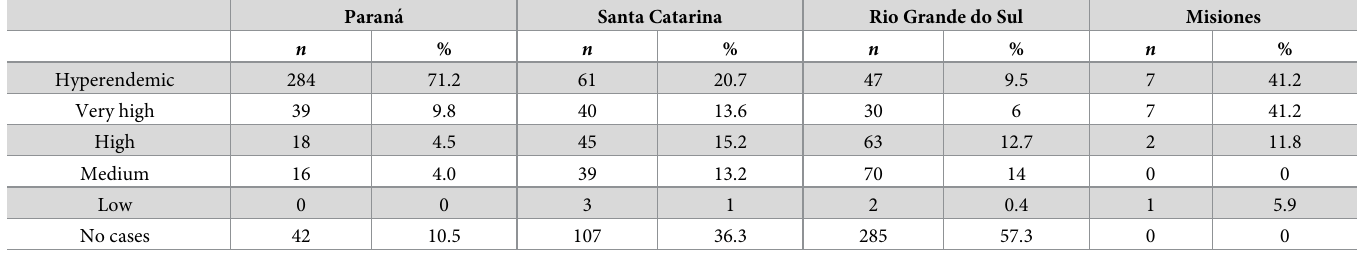
Table 1. Distribution of municipalities/departments classified according to incidence rate, in the states of Parana´, Santa Catarina and Rio Grande do Sul, Brazil and in Misiones province, Argentina in the period 2010 to 2016. Parana´